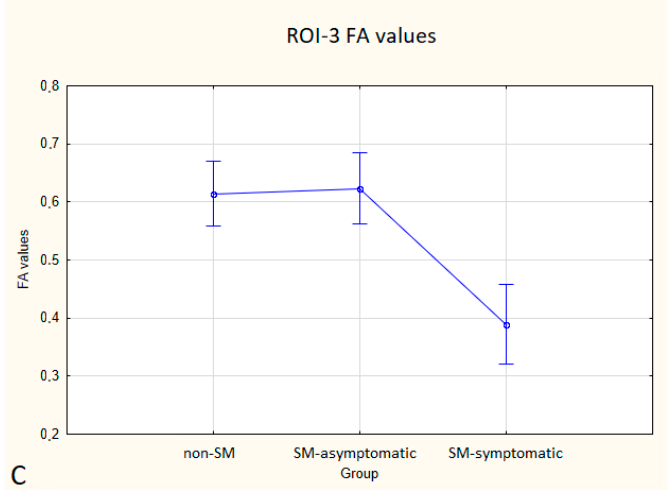
Figure 5. Boxplots comparing FA values in ROI-1 ( A ), ROI-2 ( B ), ROI-3 ( C ) between the non-SM, SM-symptomatic and SM-asymptomatic groups.